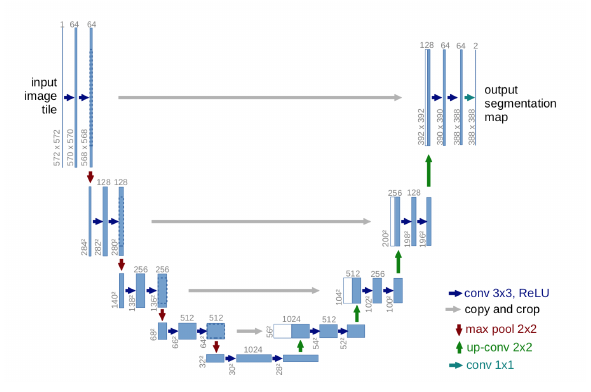
Figure 10. U-Net